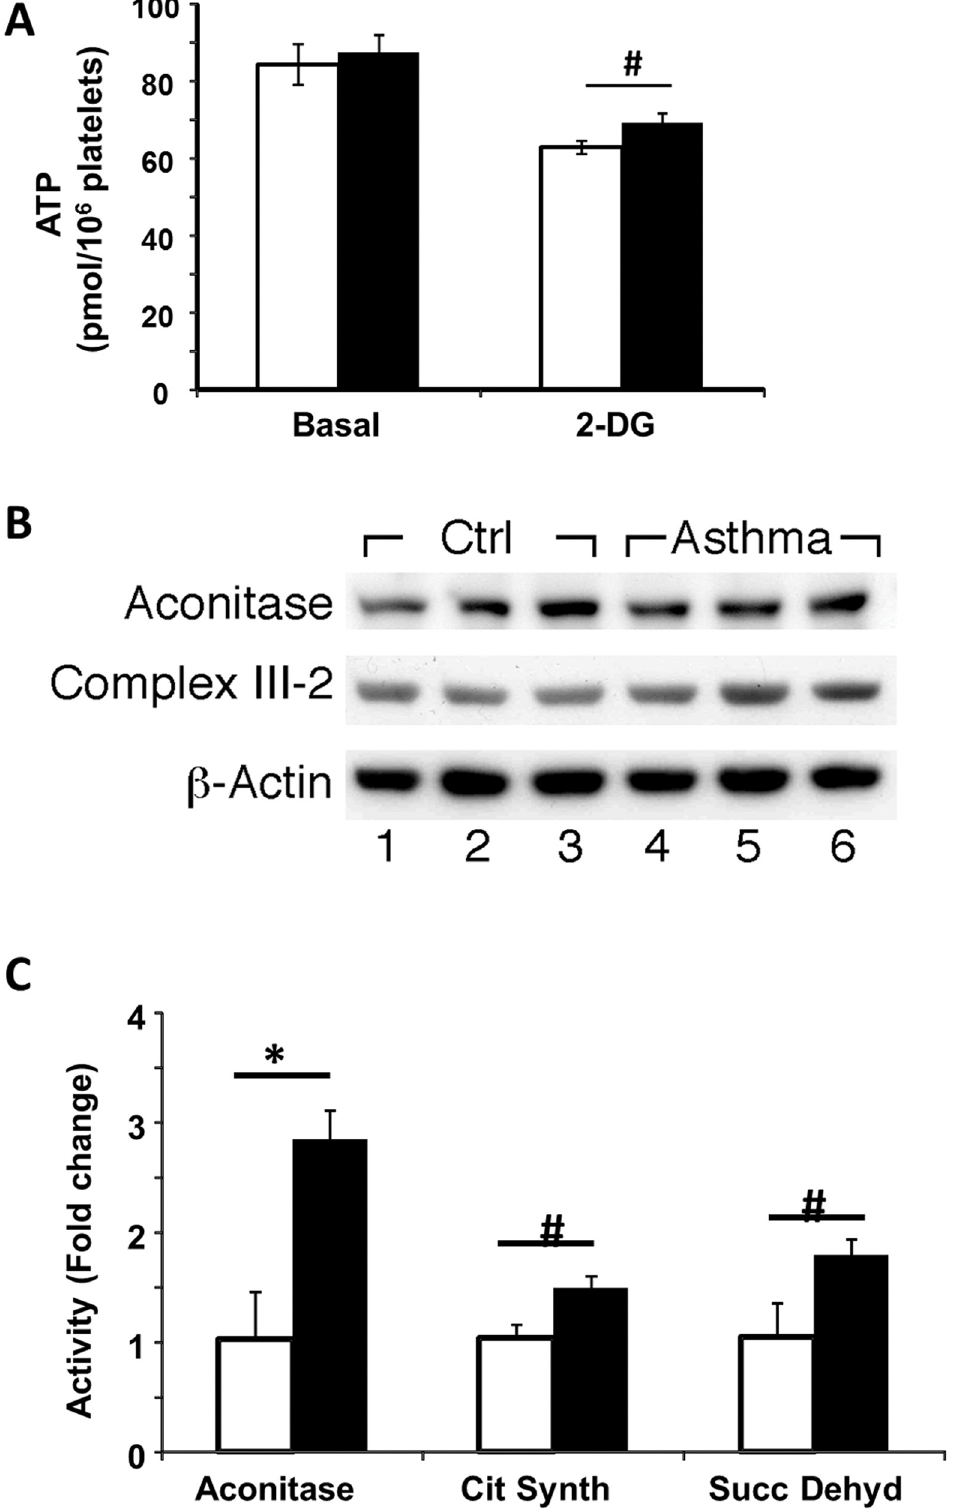
Fig 5. Greater TCA Cycle Activity in Asthma. (A) ATP content in control (white bars) and asthmatic (black bars) individuals basally and after inhibition of glycolysis by 2-DG. (B) Western analyses of aconitase expression in platelets. Asthmatic individials (lanes 4 − 6) had similar aconitase protein expression in